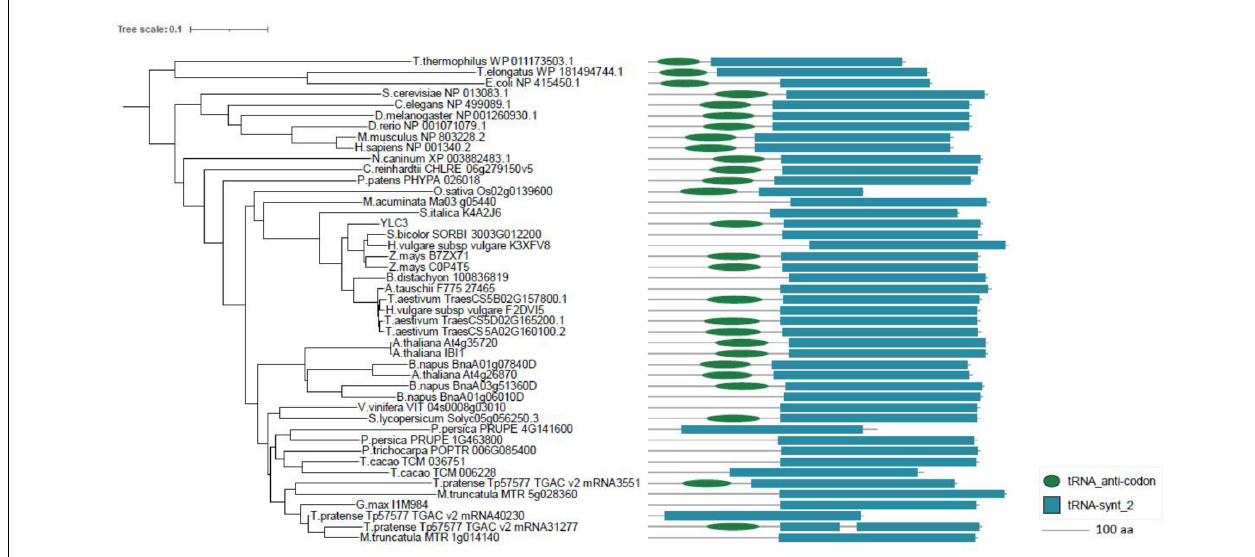
FIGURE 5 | Phylogenetic analysis and motif alignment. A phylogenetic tree was constructed with aligned full-length sequences of homologs of YLC3. Amino acid sequences from regions 101 to 188 and 223 to 544 in YLC3 were used for motif alignment by MEGA.